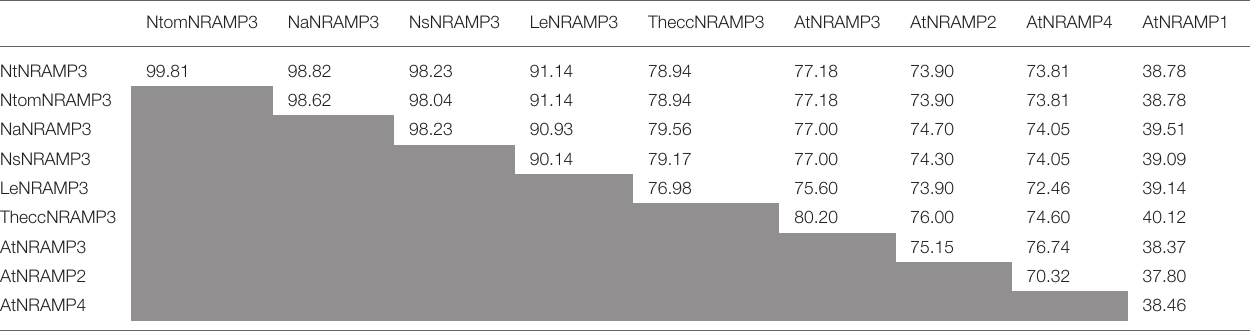
TABLE 2 | Amino acids sequence identity between selected NRAMP proteins.